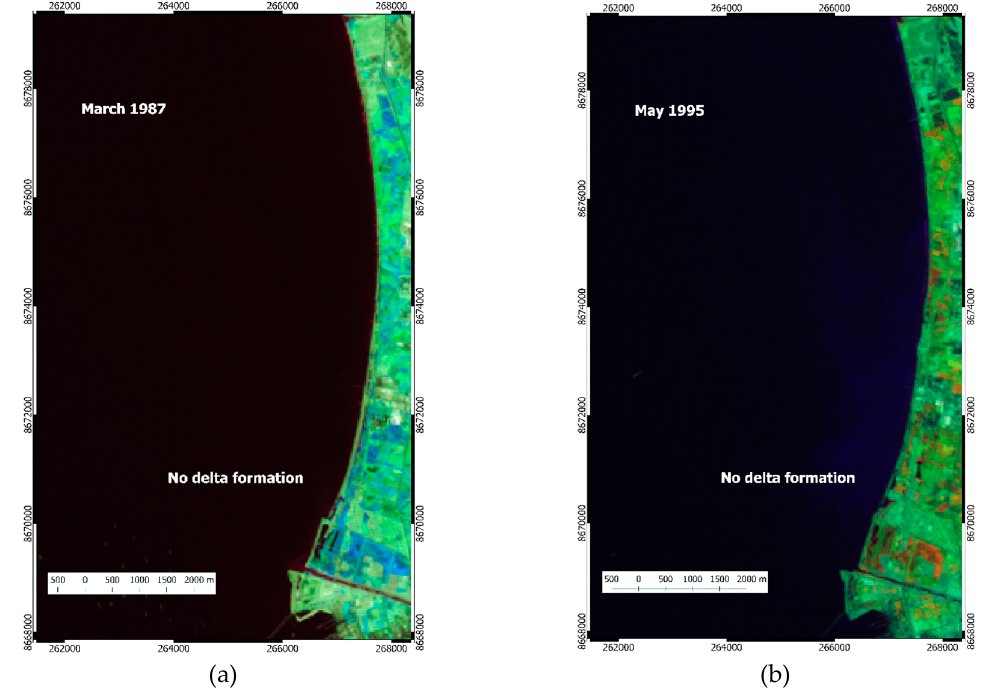
Figure 10. Rimac Delta evolution a ) during moderate EN in 1987, b ) during a weak EN in 1995.